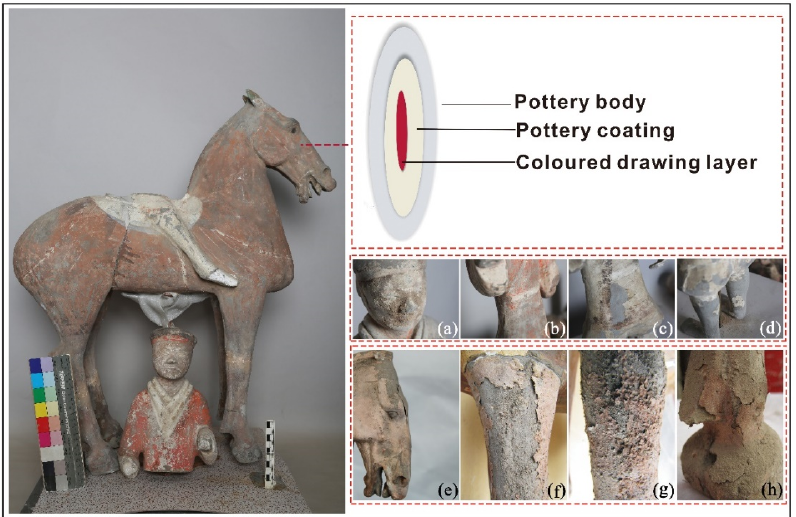
Figure 2. Structure and typical conditions of the painted layer of terracotta warriors and horses from the Western Han Dynasty; ( a ) crisp powder, ( b ) warping, ( c ) cracking, ( d ) shedding, ( e ) warping, ( f ) shedding, ( g ) crisp powder, ( h ) cracking.